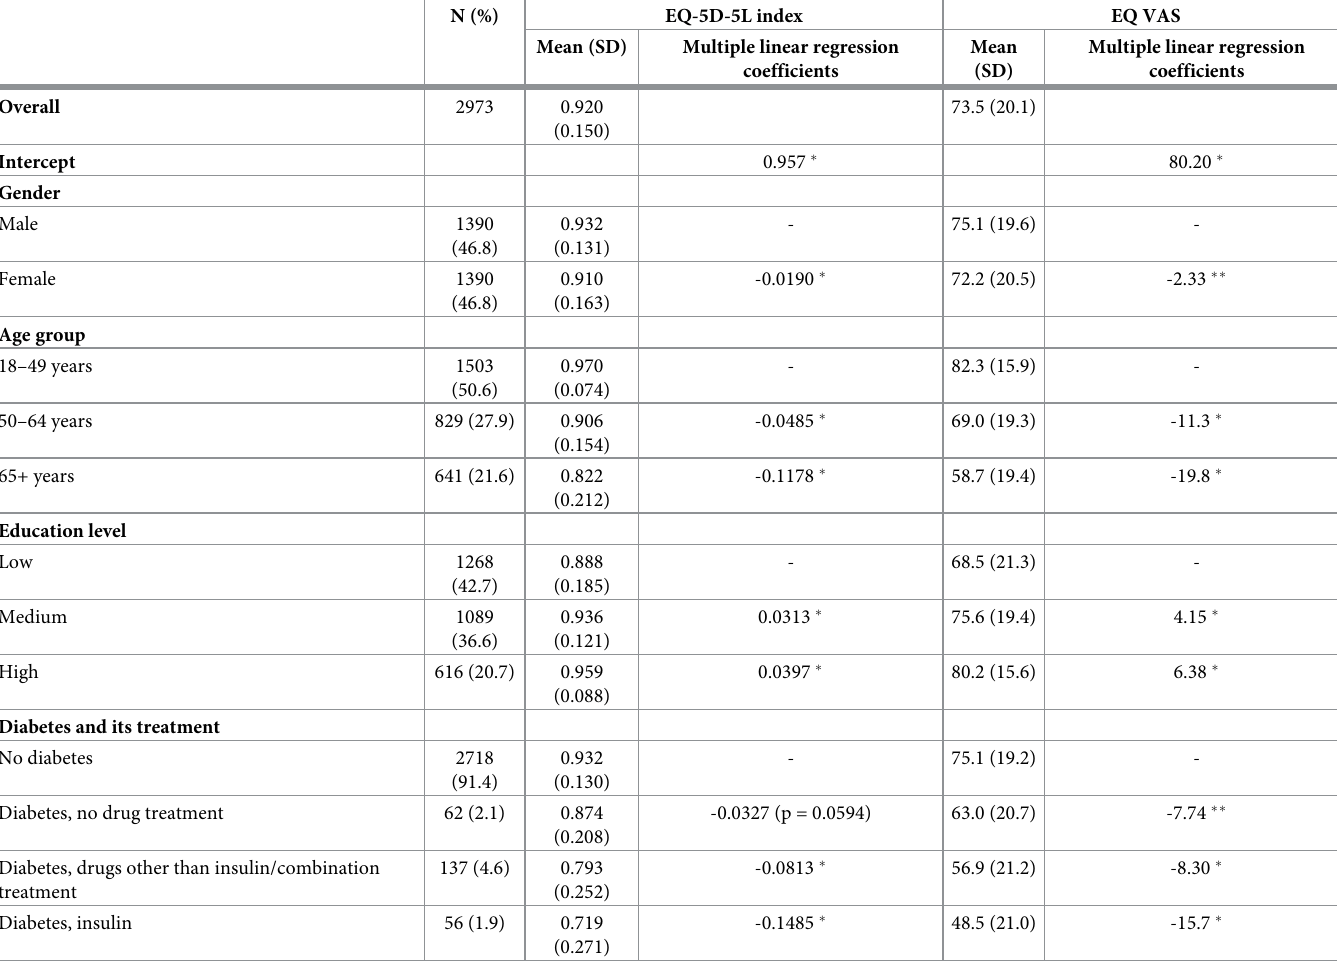
Table 6. Relation of EQ-5D-5L index and EQ VAS with demographic characteristics of the studied general population sample (n =